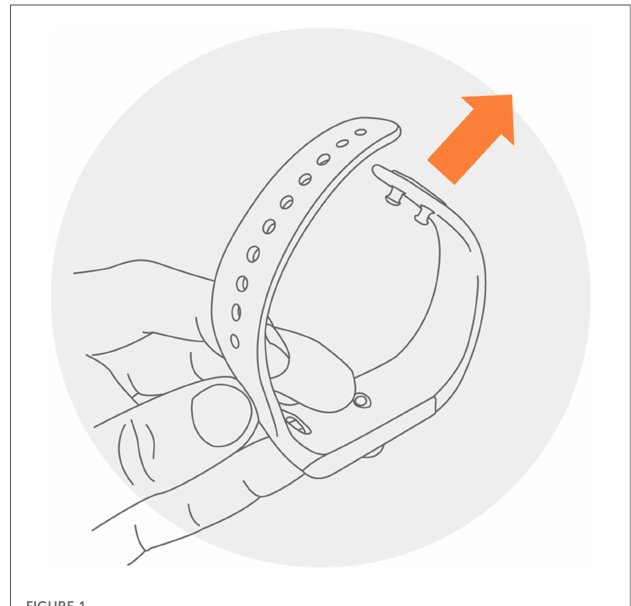
FIGURE 1 Wristband clasp